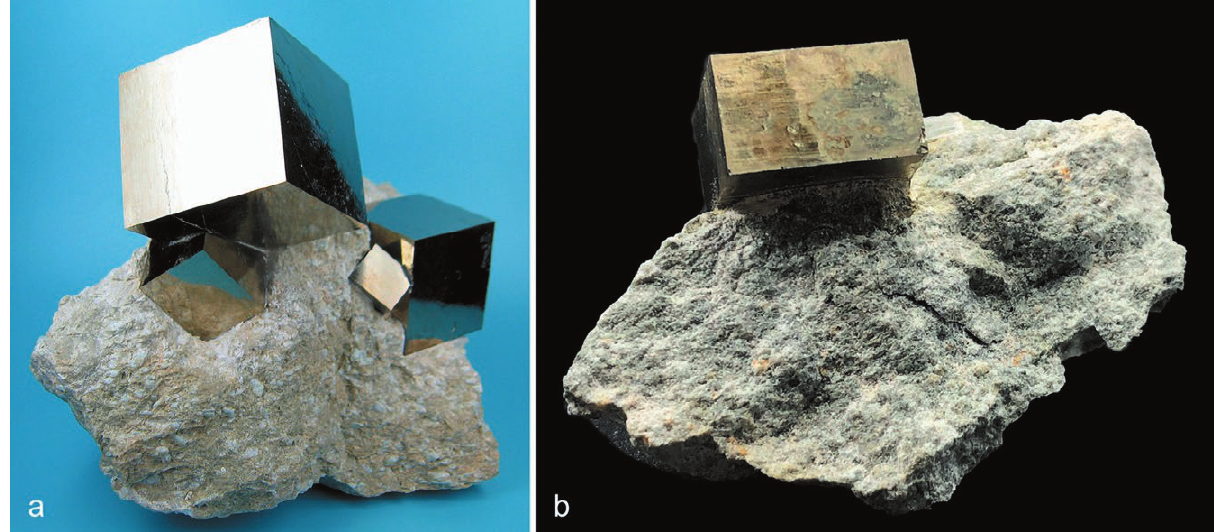
Fig. 3. Crystals of pyrite. 3a: Pyrite in geometrically regular cubes (https://en.wikipedia.org/wiki/Pyrite). 3b: “Cubes” of pyrite with rectan- gular faces (https://i.etsystatic.com/16351195/r/il/5994c7/1719730471/il_fullxfull.1719730471_rcxj.jpg).